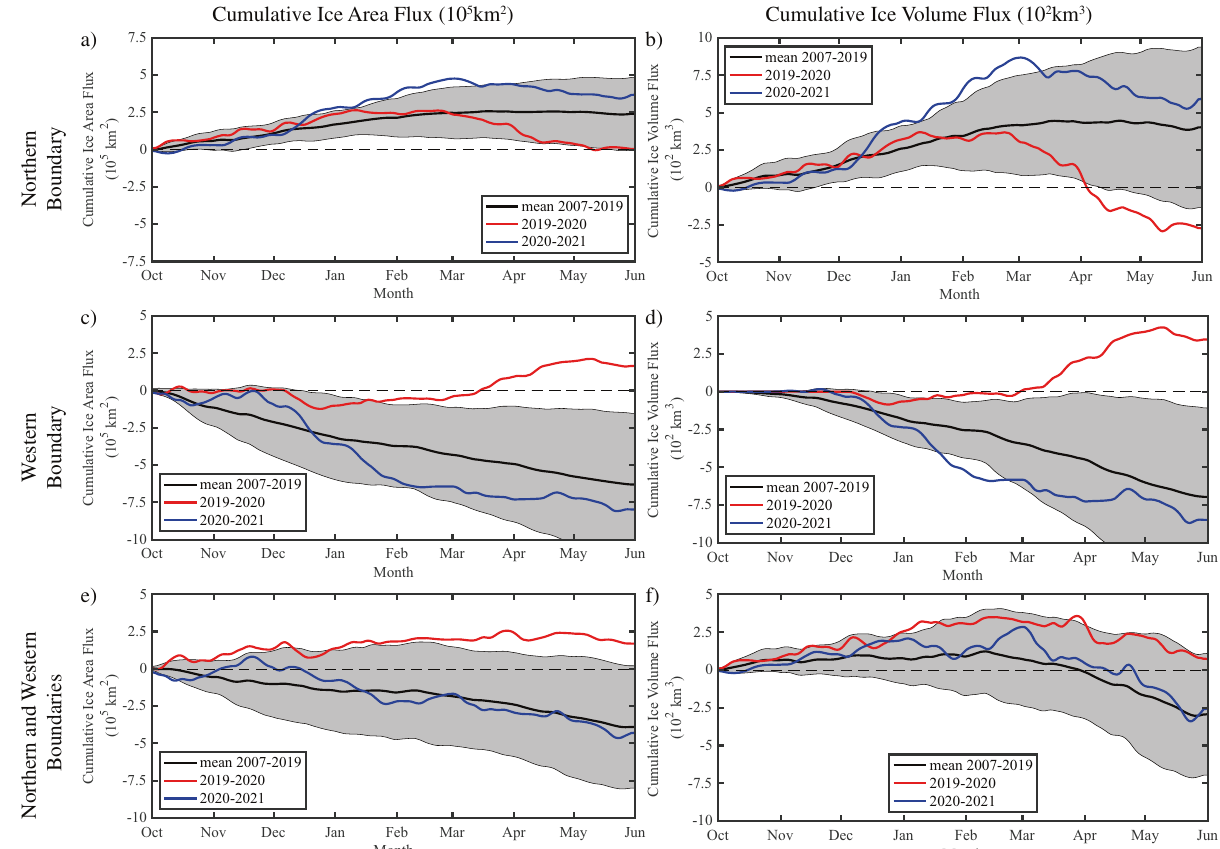
Fig. 7 Variability in the PIOMAS sea ice fl uxes into the region of interest. Cumulative: a ice area (10 5 km 2 ) fl ux and b ice volume fl ux (10 2 km 3 ) through the northern boundary of the region of interest. Cumulative: c ice area (10 5 km 2 ) fl ux and d ice volume fl ux (10 2 km 3 ) through the western boundary of the region of interest. The net cumulative: e ice area (10 5 km 2 ) fl ux and f ice volume fl ux (10 2 km 3 ) through the northern and western boundaries of the region of interest. Results are shown for climatology (2007 – 2019) as well as for 2019 – 2020 and 2020 – 2021 with the shading representing + / − one standard deviation above/below the climatological mean. Positive fl uxes are into the region of interest.